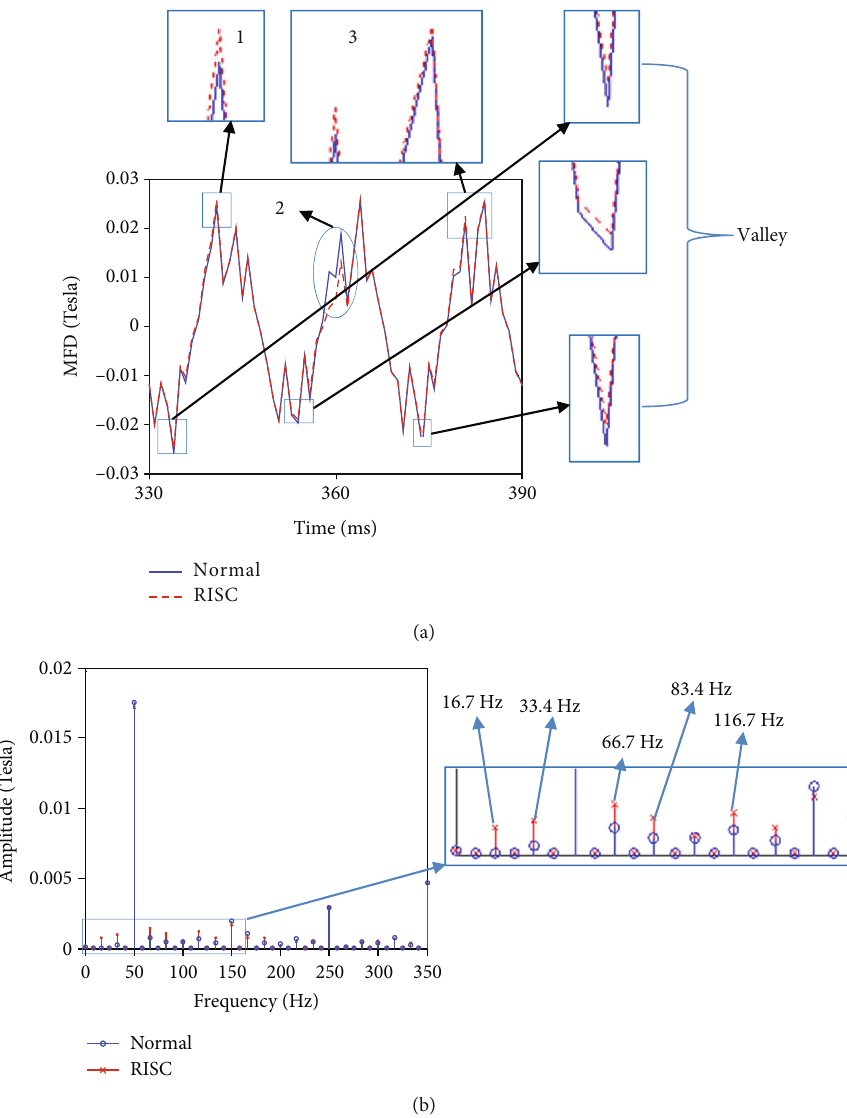
Figure 6: Radial fl ux density of the MJF-30-6 simulator: (a) time wave and (b)